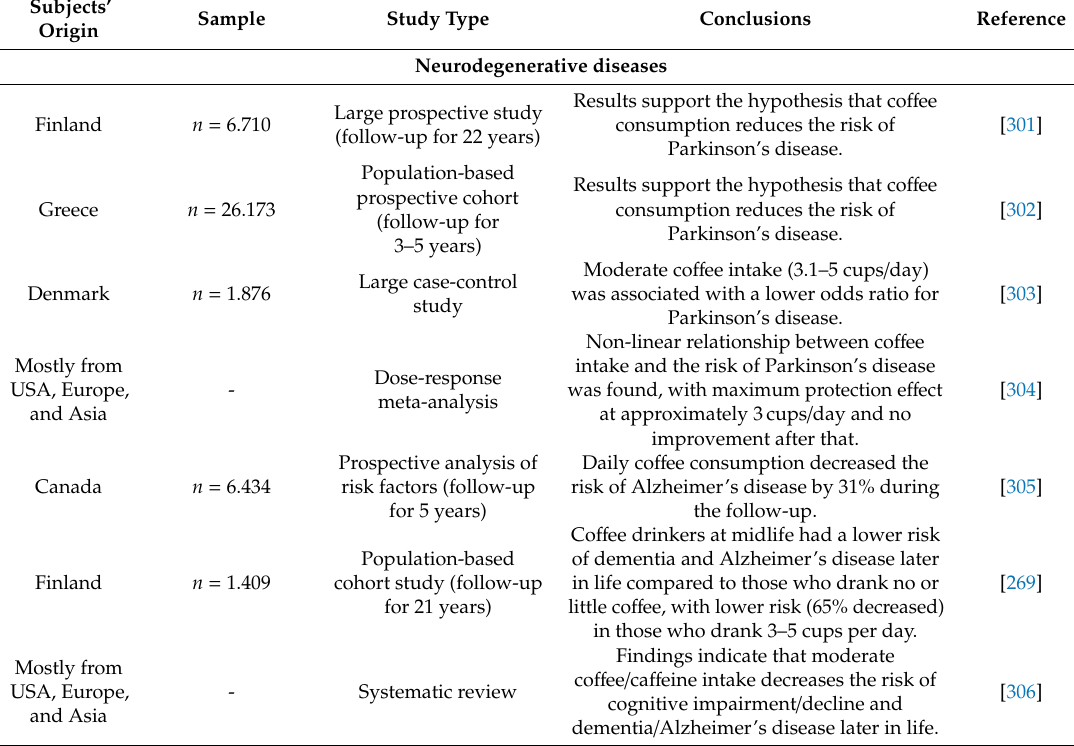
Table 3. Complementary studies on the protective e ff ect of ca ff eine against neurodegenerative and hepatic